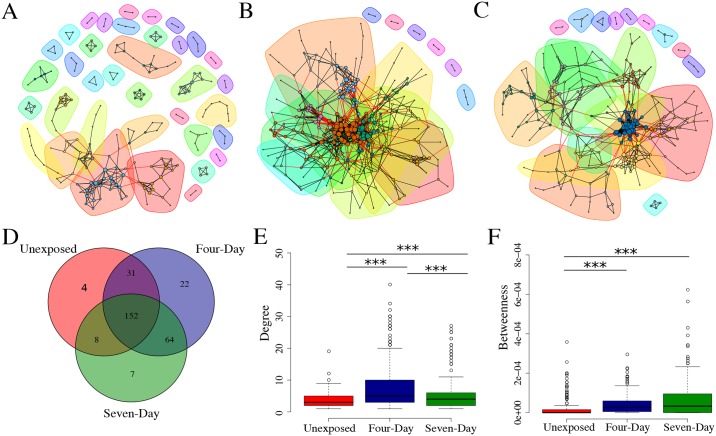
Triclosan exposure is associated with alterations in microbial correlation networks.Interaction networks for microbial communities in (A) unexposed, (B) four-day exposure and (C) seven-day exposure groups. Network communities (subgraphs) are identified by colored polygons and the vertices (OTUs) that comprise these communities are colored identically to indicate network community membership. Each line represents an abundance correlation between two OTUs. The size of each vertex is proportional to its degree. Edges between different network communities are colored red and those within a community are black. (D) Venn diagram of shared vertices between networks. (E) Degree and (F) betweenness centrality distribution for all vertices in network. *** p < 0.001.